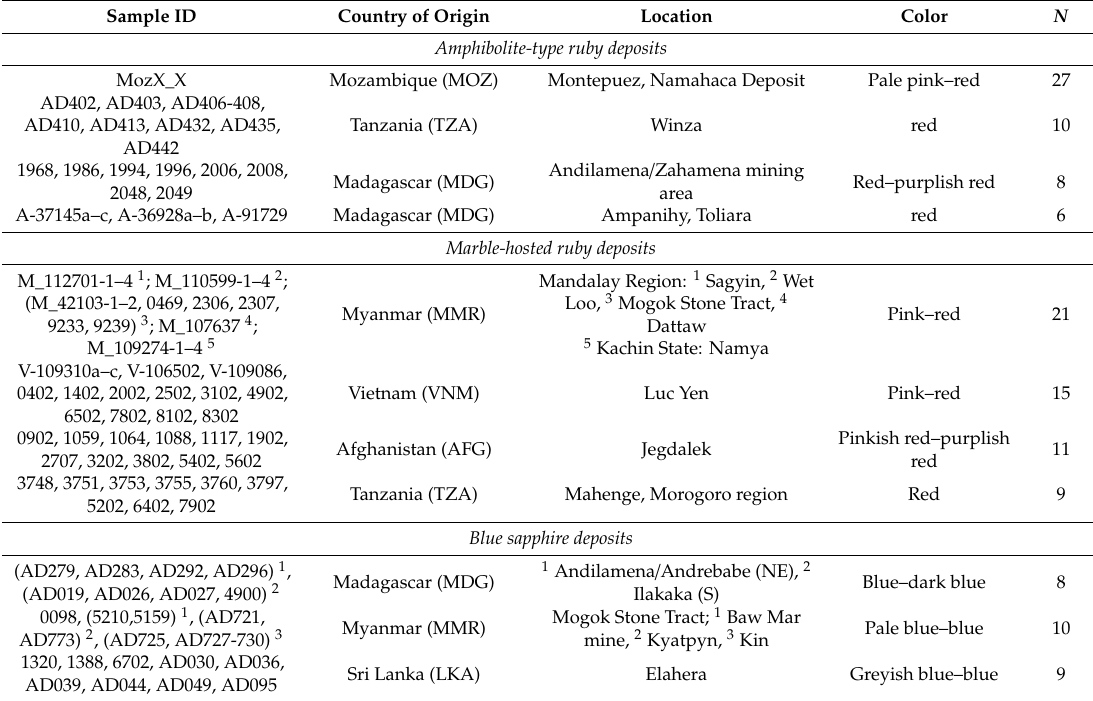
Table 1. Samples analyzed in this study. MozX_X samples were provided by A. Fagan, Hummingbird consulting, Vancouver. All ADXXX and four-digit samples are part of Gemological Institute of America’s (GIA) research collection. All samples named A_XXX, V_XXX and M_XXX were provided by George Harlow from the American Museum of Natural History, New